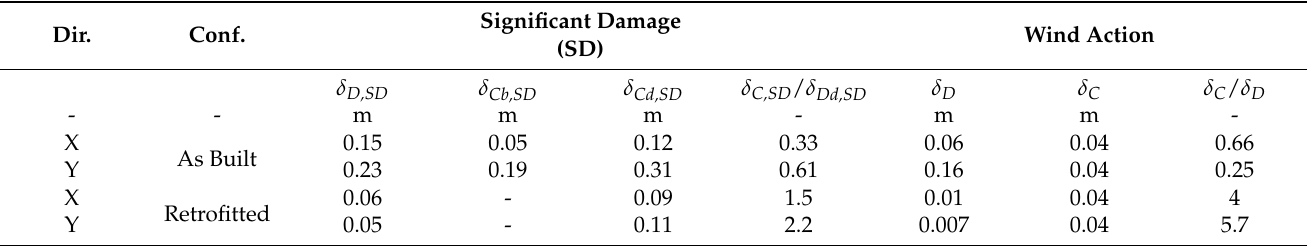
Table 3. Seismic and wind checks for the retrofitted structure in terms of displacements.